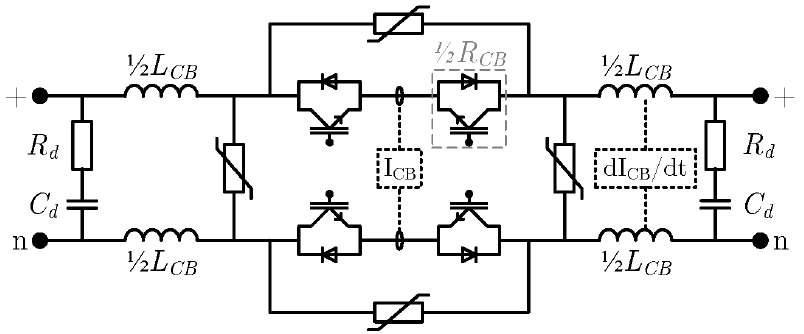
Figure 14. Proposed solid-state circuit breaker topology with added RC